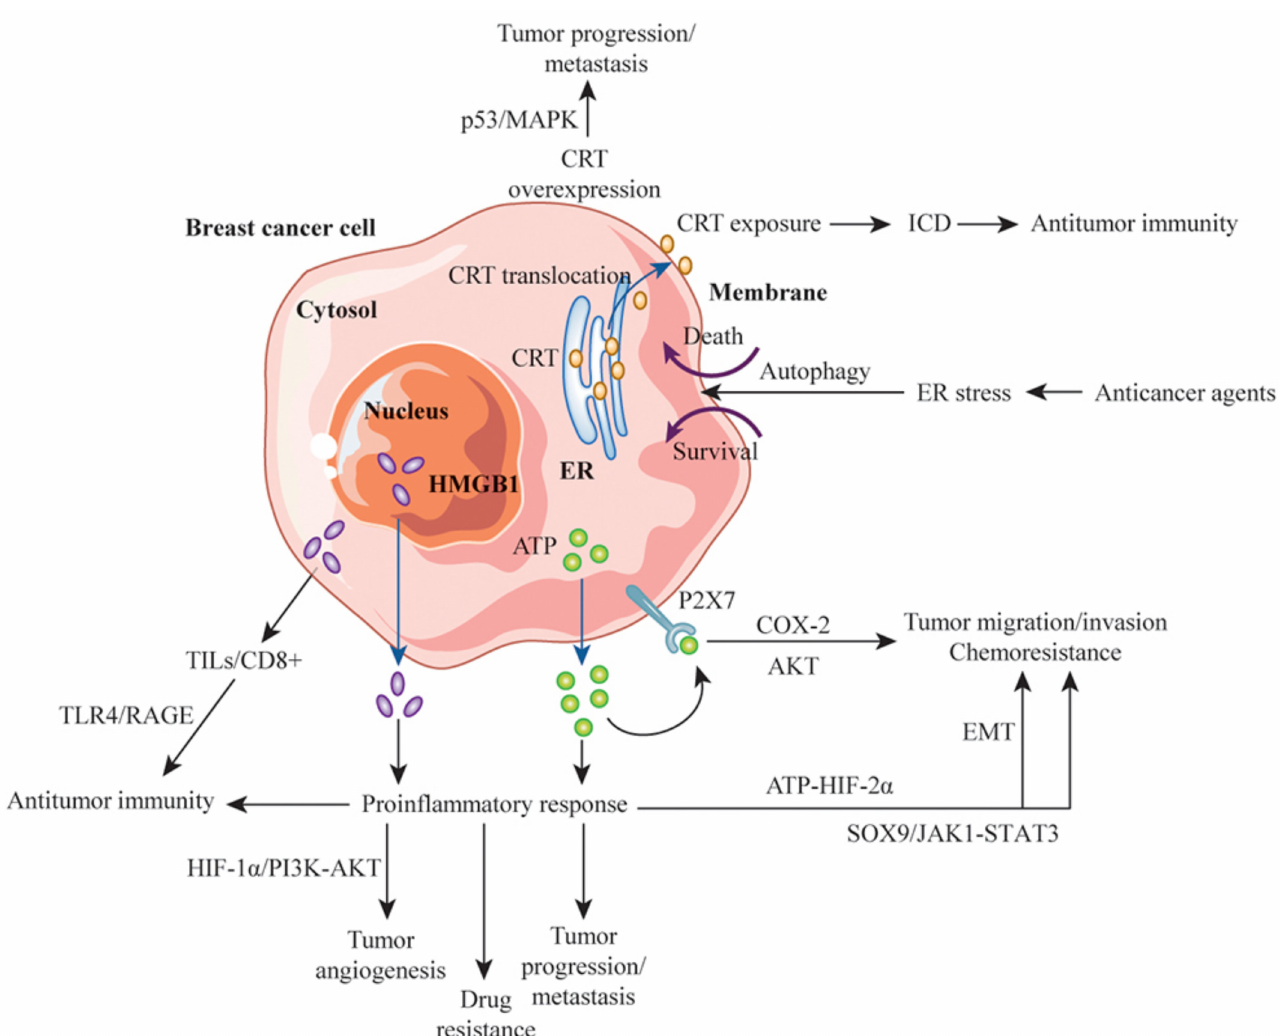
Figure 3. The dual roles of DAMPs in antitumor immunity and tumor development in breast cancer cells. Anticancer agents induce an ER stress response and autophagy, which determines whether cells die or survive. When cells die, CRT in the ER lumen migrates to the tumor cell membrane, exposing the CRT/ERp57 complex as an “eat me” signal. This signal induces an antitumor immune response via ICD-mediated signals. CRT overexpression is asso- ciated with tumor progression and metastasis via the MAPK signaling pathway. Nuclear HMBG1 is released extracellularly to trigger inflammatory responses and is involved in tumor progression, metastasis, angiogenesis, drug resistance, and antitumor immunity in response to the tumor microenvironment and external stimuli. In TN breast cancer, cytoplasmic HMGB1 is associated with increased numbers of TILs, which are involved in antitumor immunity. ATP, which is secreted abundantly extracellularly, binds to P2X7 receptors on breast cancer cells and is involved in tumor migration and invasion. Extracellular ATP also triggers an inflammatory response and is involved in tumor migration, invasion, and chemotherapy resistance due to EMT. DAMPs, such as CRT, HMBG1, and ATP, in breast cancer cells play dual roles in tumor progression and antitumor immunity, depending on the magnitude and duration of external stimuli in the tumor